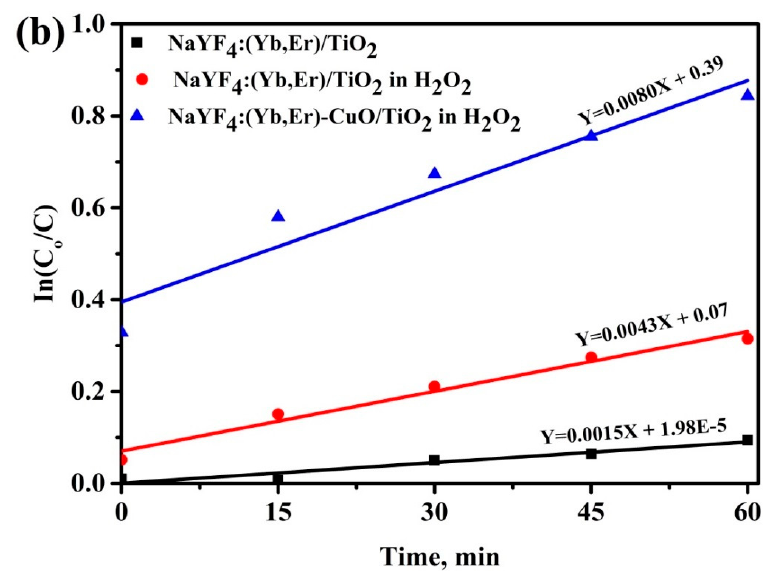
Figure 6. Degradation efficiency of methylene blue (MB) solutions mixed with ( a ) NaYF 4 :(Yb,Er)- CuO/TiO 2 composites and ( b ) rate kinetics for the samples in ( a ).